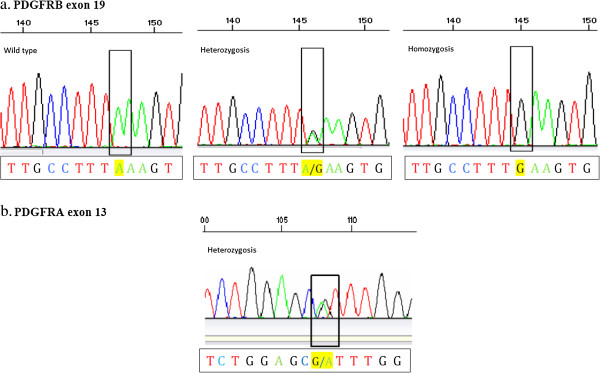
Electropherogram of a PDGFR sequence. 1a: Three examples of paraffin-embedded tumour tissue DNA sequence analysis of PDGFRβ exon wild type (Adenine), and SNP B19 in heterozygosis and homozygosis (A to G transition), respectively. 1b: DNA sequence of a paraffin-embedded tumour tissue sample presenting PDGFRα exon 13 SNP in heterozygosis (G to A transition).